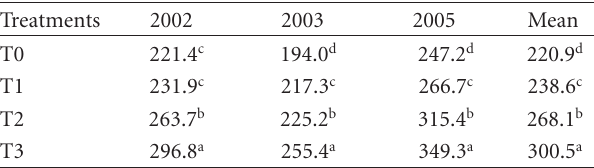
Table 3: PAR capture ratio in the canopy of summer maize (%).